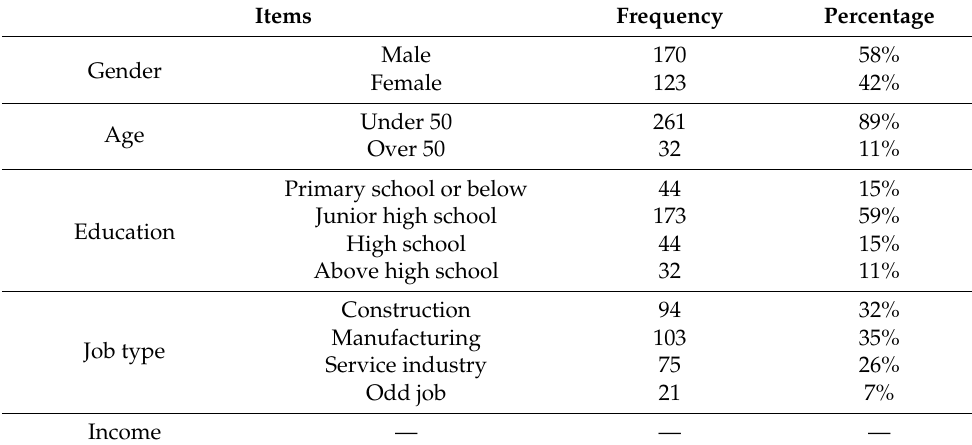
Table 3. Information of migrant